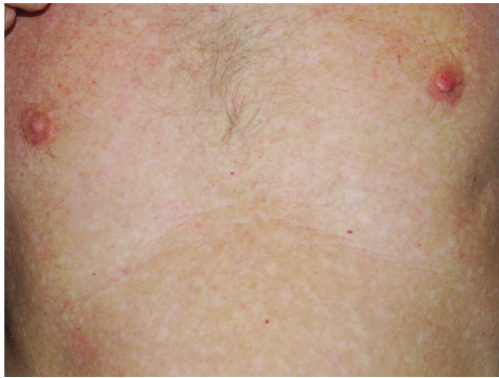
Figure 1: Enlarged left nipple. Clinical appearance of BCC on the left nipple. Erosion on the surface represents the biopsy site.